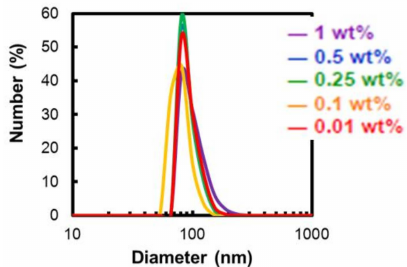
Figure 3. Effects of P 400 -OC 12 H 25 concentration on micelle size